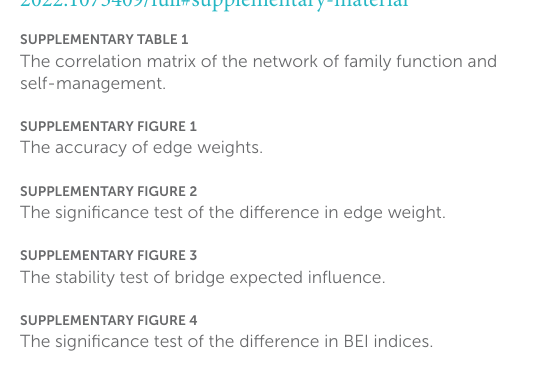
SUPPLEMENTARYFIGURE2 The significance test of the difference in edge weight. SUPPLEMENTARYFIGURE3 The stability test of bridge expected influence. SUPPLEMENTARYFIGURE4 The significance test of the difference in BEI